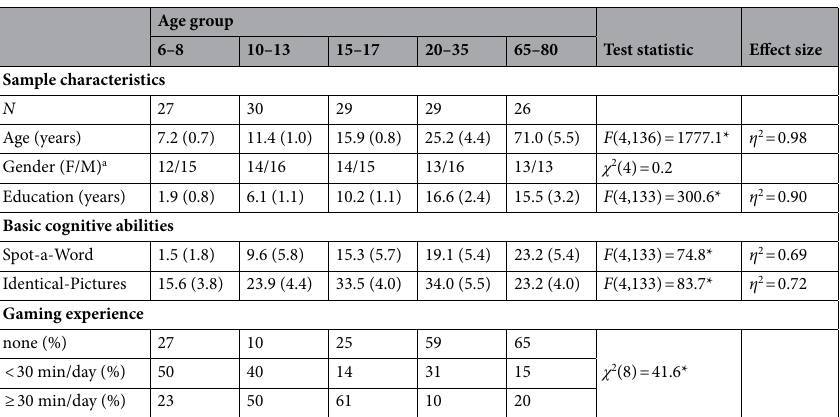
Table 1. Demographic characteristics, cognitive covariates, and computer/video gaming experience by age group. Scores represent means and standard deviations (in parenthesis). Years of education are computed as the sum of school, university, and other education years. The Spot-a-Word (SAW) and the Identical-Pictures (IDP) test scores represent the mean numbers of correct responses (see text for between age group differences in some of these measures); a gender refers to sex without information about gender identity; * p <